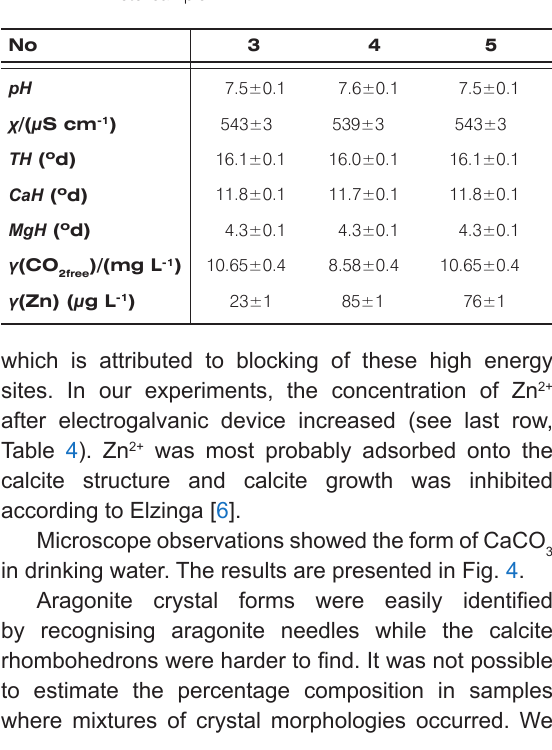
Table 4. Physico-chemical analyses of treated samples taken from hotel